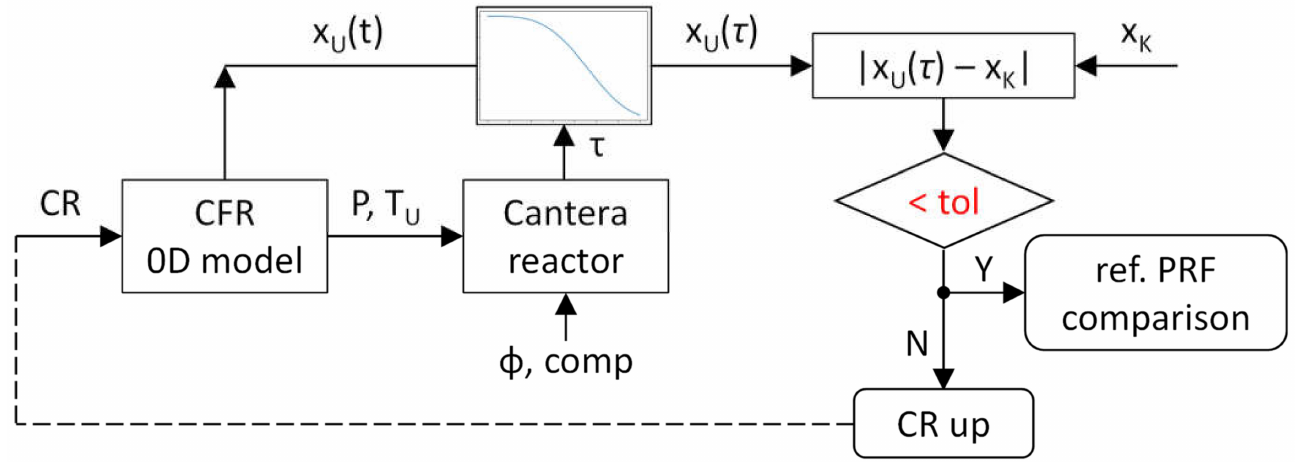
Figure 3. Workflow of the thermodynamics-chemical kinetics algorithm for the CR up-driven RON numerical